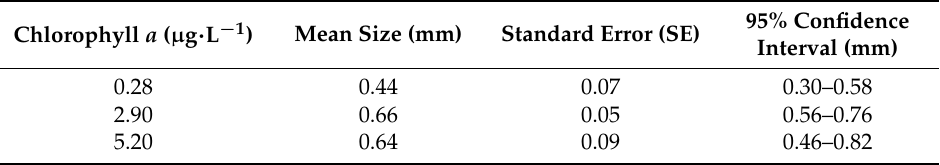
Table A1. Mean sizes for newly-metamorphosed starfish reared in the laboratory under naturally occurring chlorophyll a concentrations